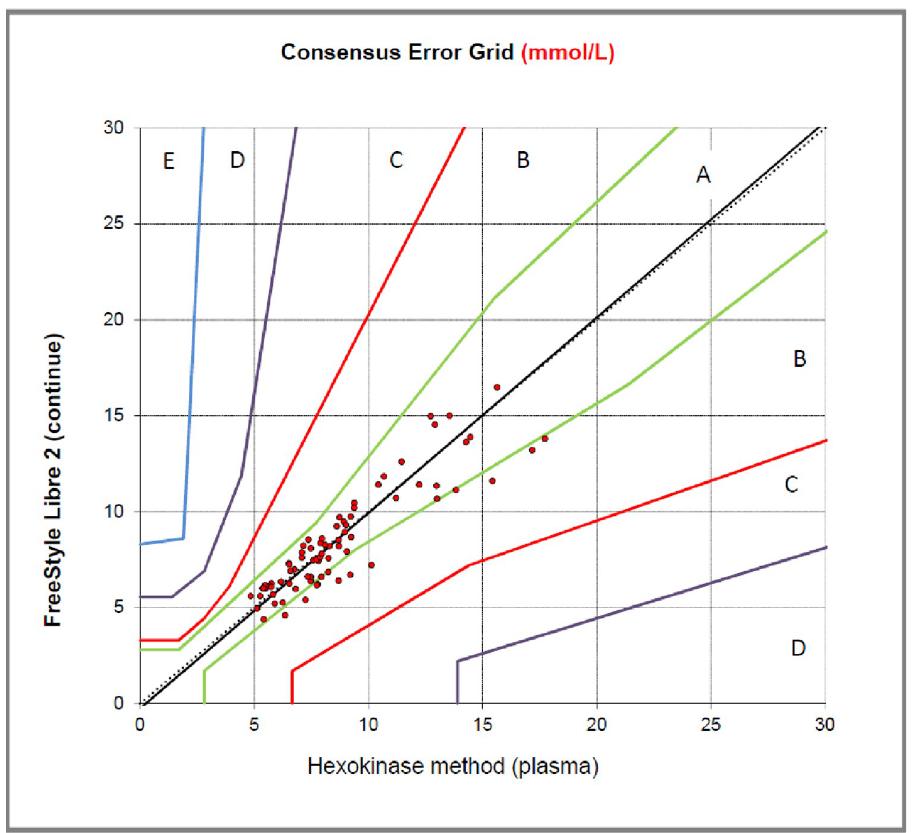
Fig 1. Parkes error grid of glucose levels with Freestyle Libre sensor versus capillary measurements. � Error grid of glucose levels with Freestyle Libre sensor versus venous measurements shows similar results.